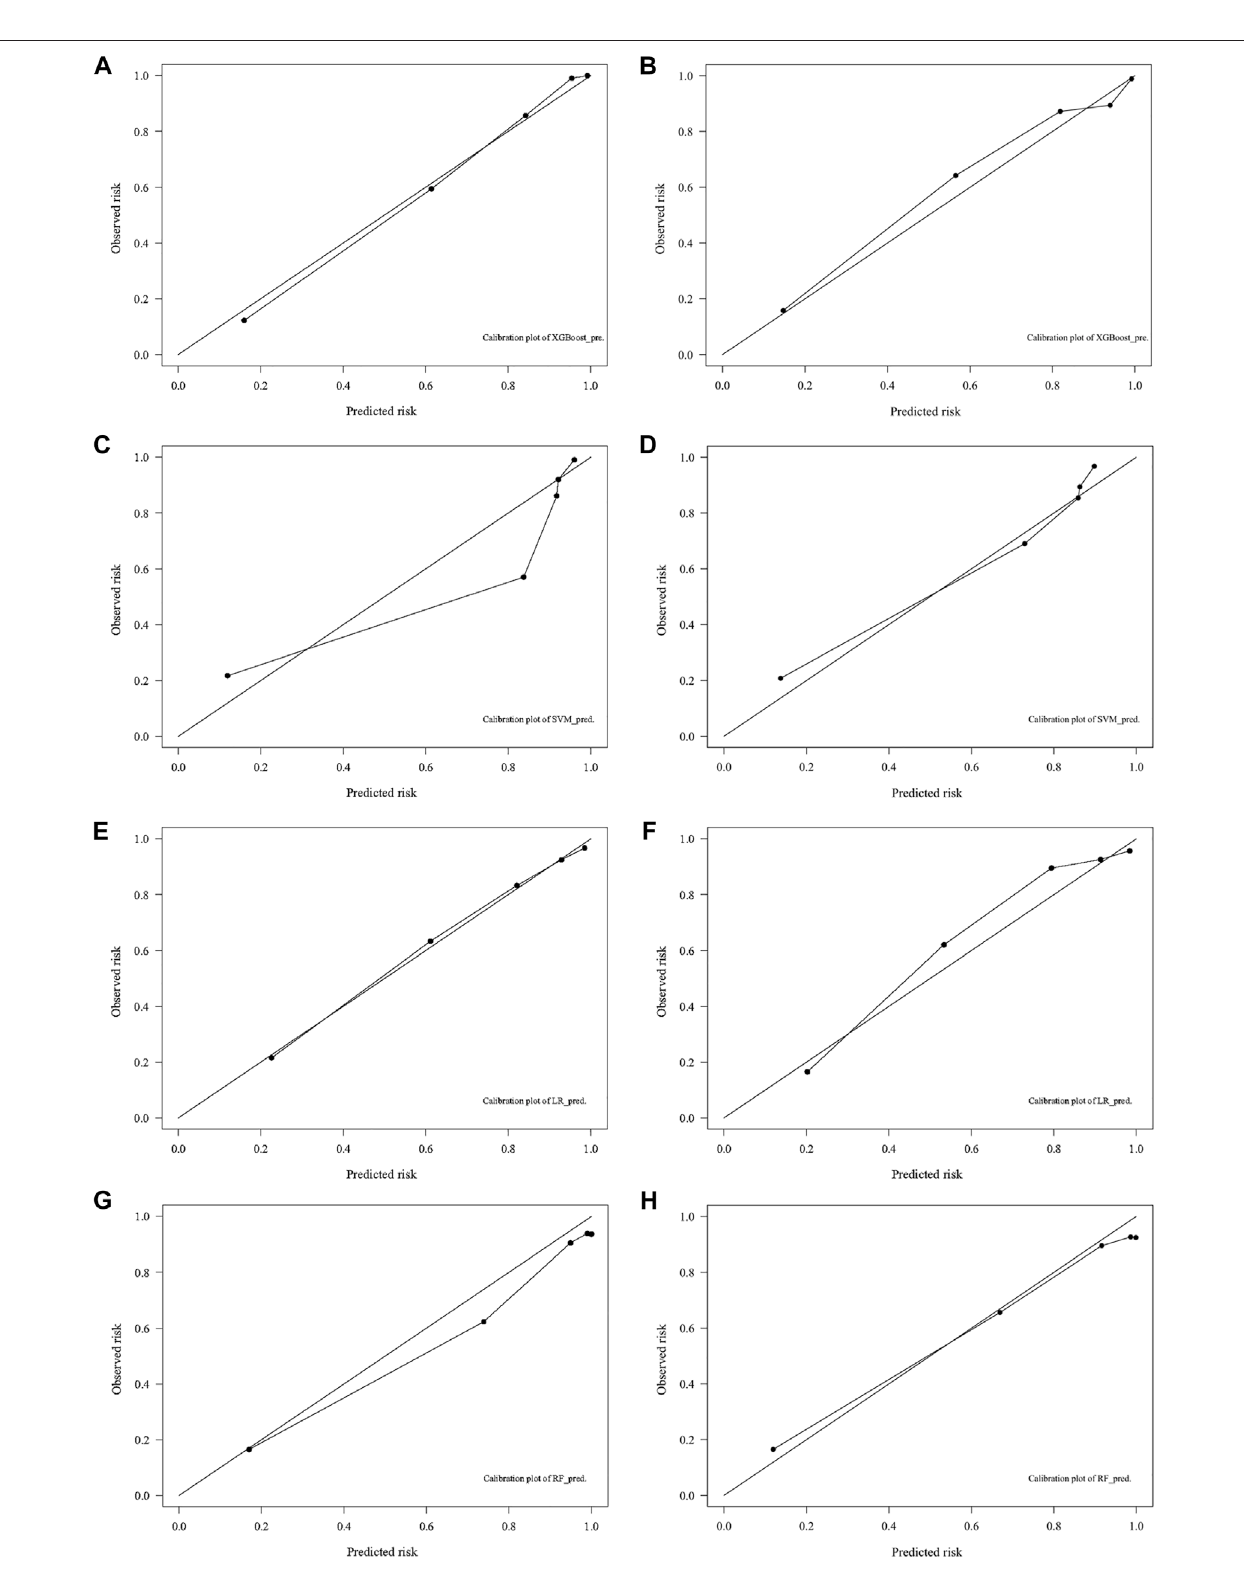
FIGURE 5 | Calibration plots for predicting 10-years DTC development with DM in the training (A,C,E,G) and test (B,D,F,H) cohorts. DTC: differentiated thyroid cancer, DM: distant metastasis, XGB: XGBoost, SVM: support vector machines, RF: random forest, LR: logistic regression.